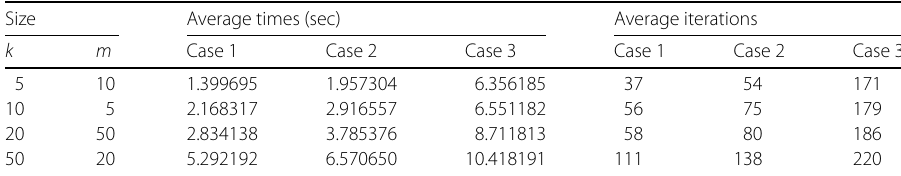
Table 2 The numerical results for the split equilibrium problem of Example 5.2 Size Average times (sec) Average iterations k m Algorithm 3.1 PEA Algorithm 3.1 PEA